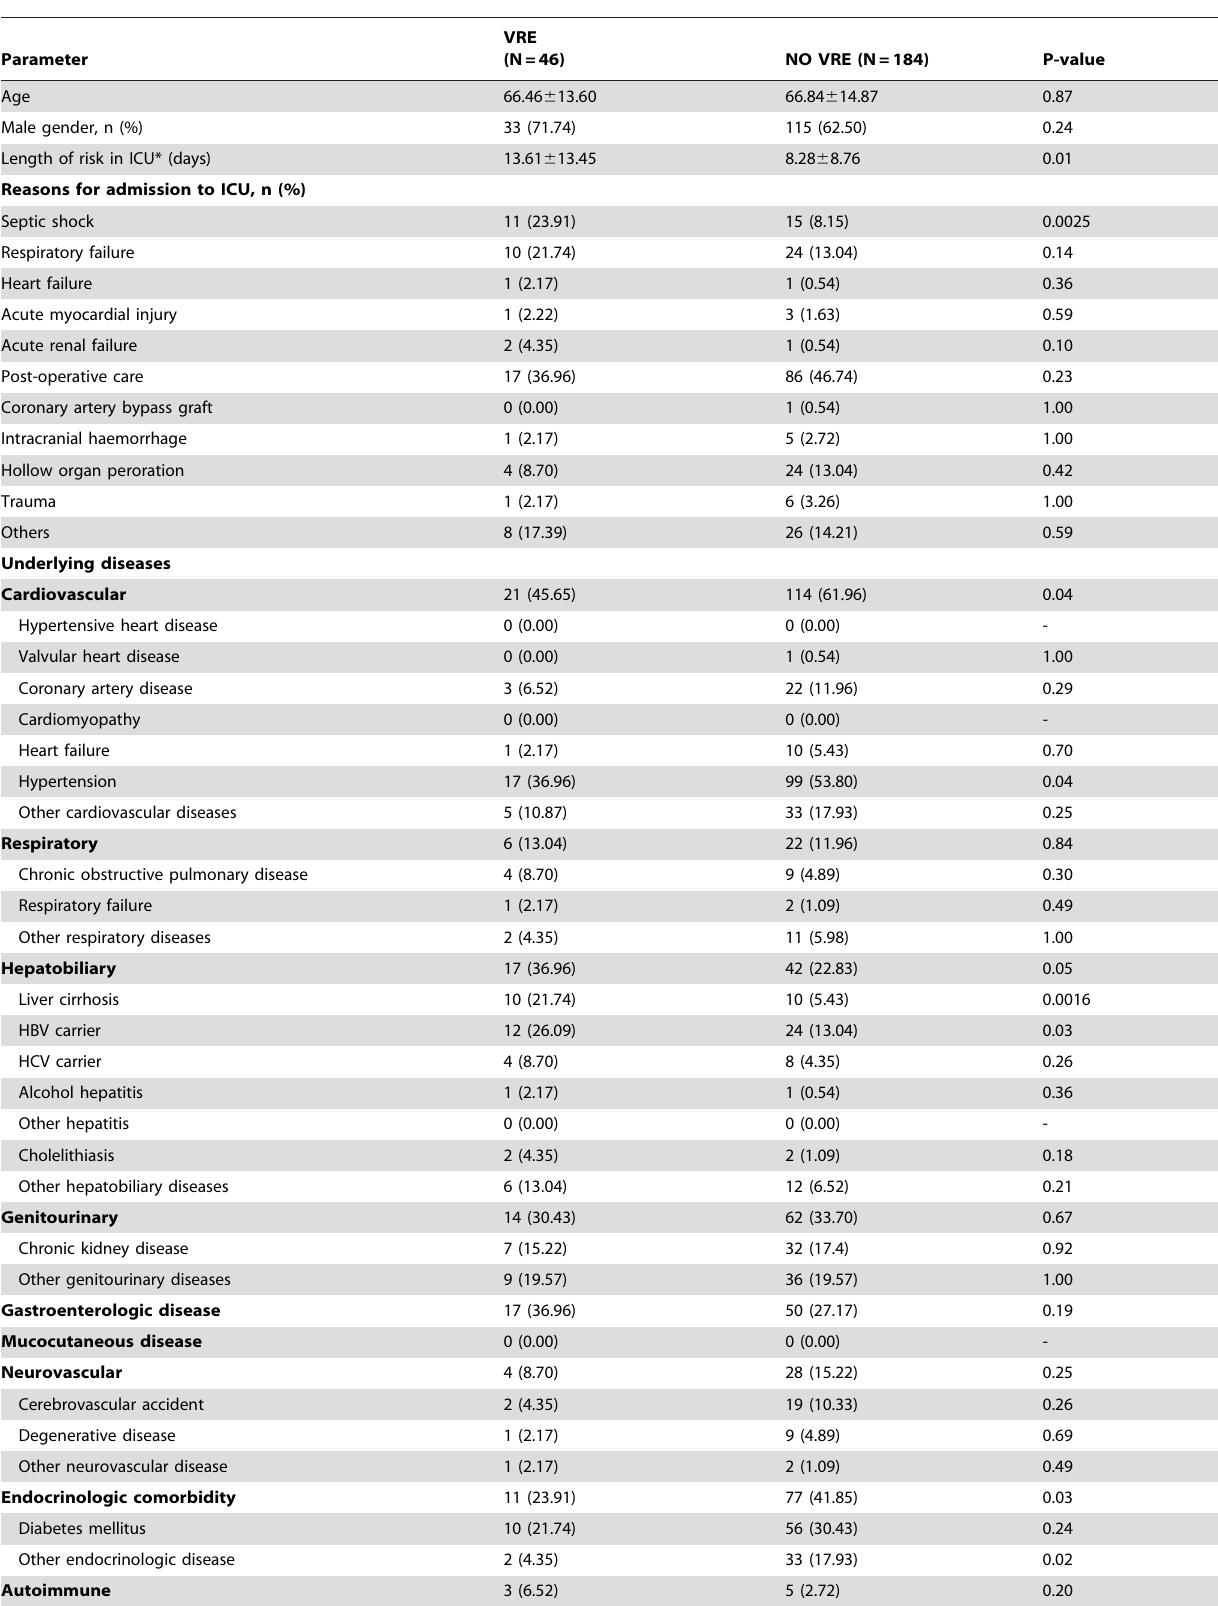
Table 1. Demographic and clinical data from 46 patients who acquired VRE in the ICU and 184 control